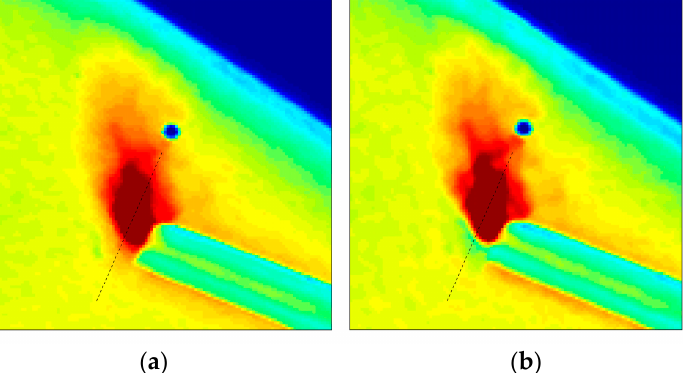
Figure 15. Comparison of ( a ) invariant and ( b ) iterative restorations for the rotating disk. The dashed black line represents the location that was used to plot the profile in Figure 16. Color represents the intensity captured in the Gate 2 image. Rotation is counterclockwise; images are in Cartesian coordinates.